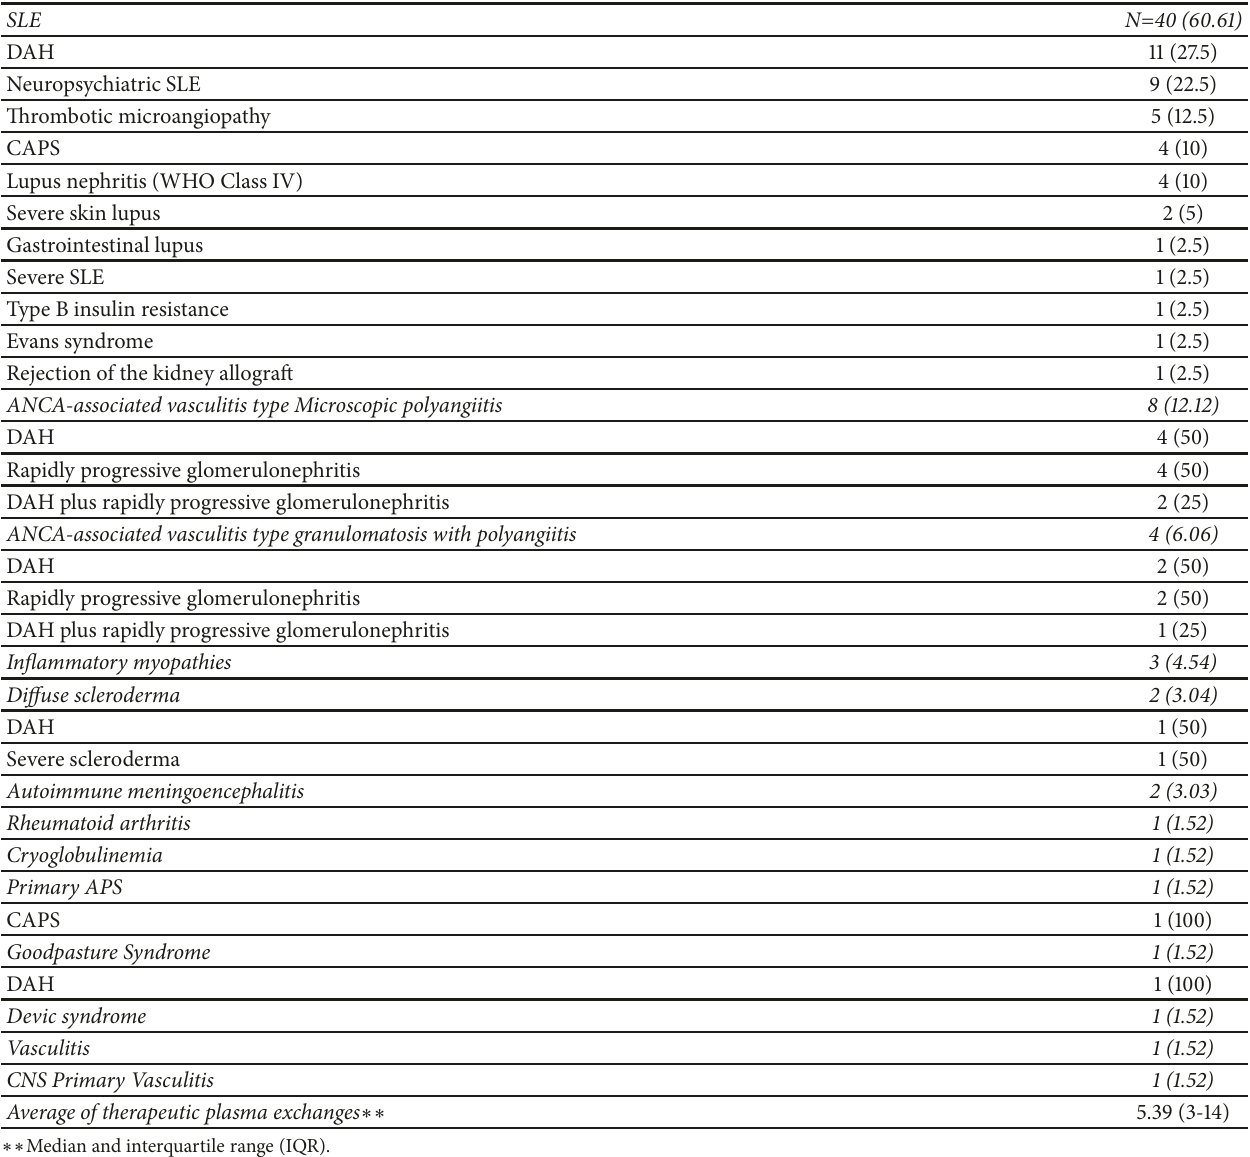
Table 1: Autoimmune disease and therapeutic plasma exchange (TPE)